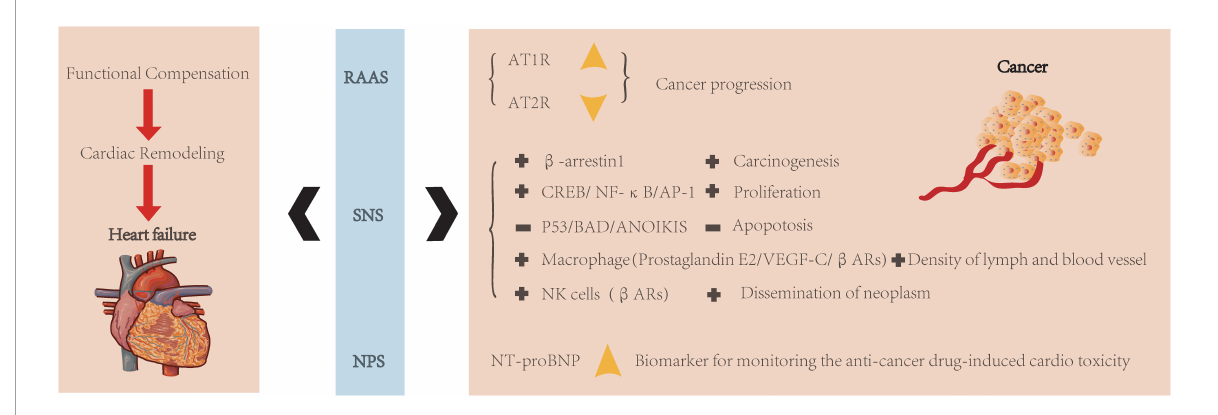
FIGURE2 Neuroendocrine regulation of heart failure and cancer. Neuroendocrine system (RAAS, SNS, and NPS) is related to both heart and cancer. They were always aroused to realize functional compensation, but following with cardiac remodeling and then leads to heart failure. In RAAS, increased AT1R and decreased AT2R were associated with cancer progression. In SNS, various kinds of signaling pathways are related to cancer progression (+: increased expression; -: decreased expression). In NPS, NT-proBNP could be a biomarker for monitoring anti-cancer treatment-induced